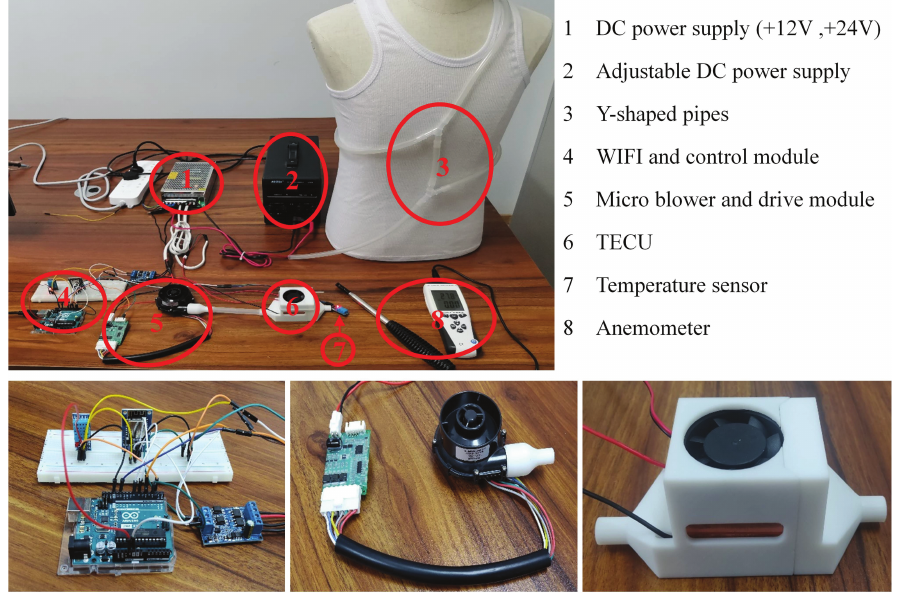
Figure 11. Testing platform for the